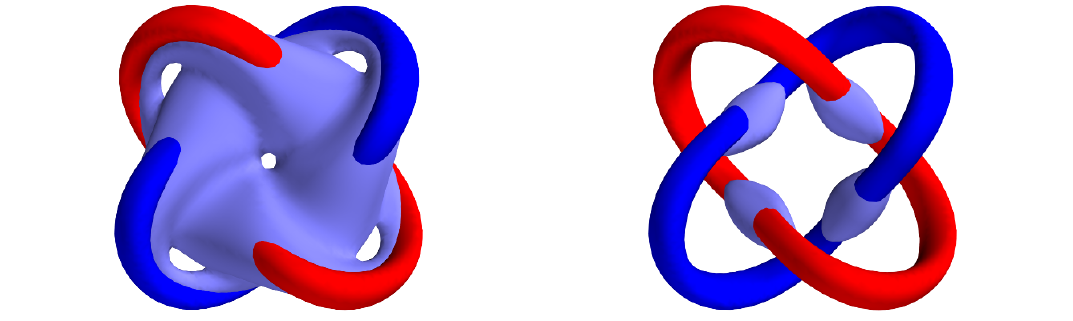
Figure 5 . Isosurfaces showing the energy density of the 2( e A 1 G e A 1 ) A Skyrme model (2.4) with the potential V = m 2 (cid:30) 12 at c 2 = 0 : 5 ; c 4 = 1 ; m = 4 for E = 52 (left) and E = 90 (right) together with the location curves (cid:30) 1 = (cid:6) 0 :